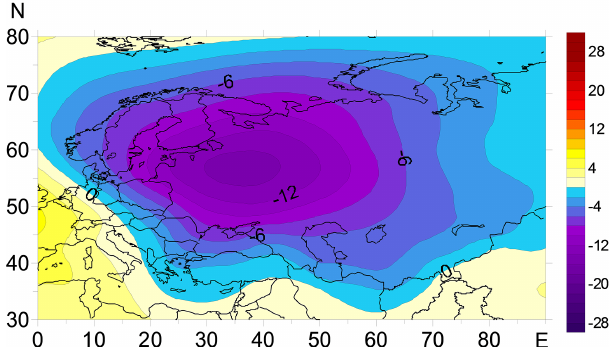
Figure 22. Composite of SLP anomaly corresponding to the first weather regime of storm days [hPa].